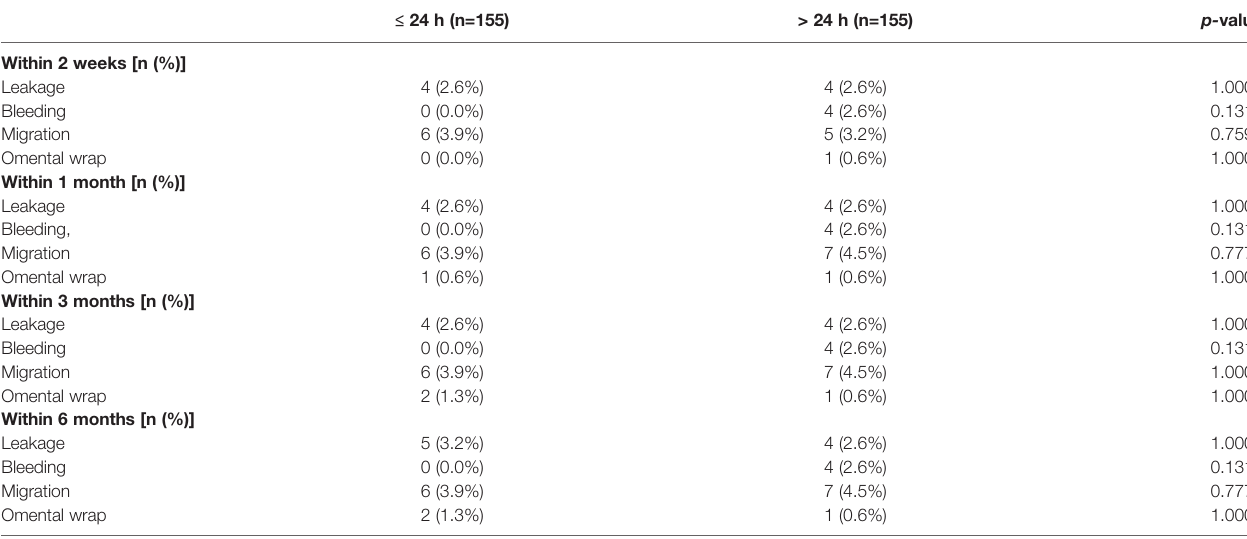
TABLE 2 | Mechanical complications between different BI in diabetics with urgent PD within varies follow-up time.